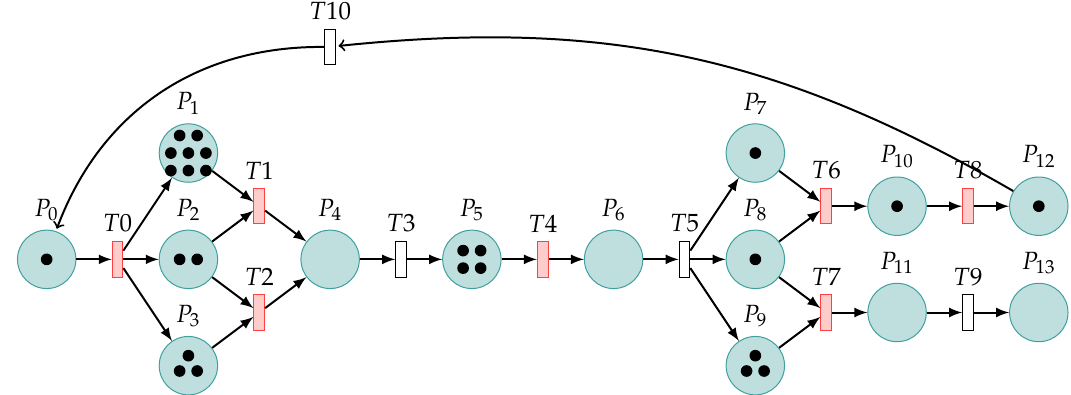
Figure 4. The model reaches a safe state for the first time.